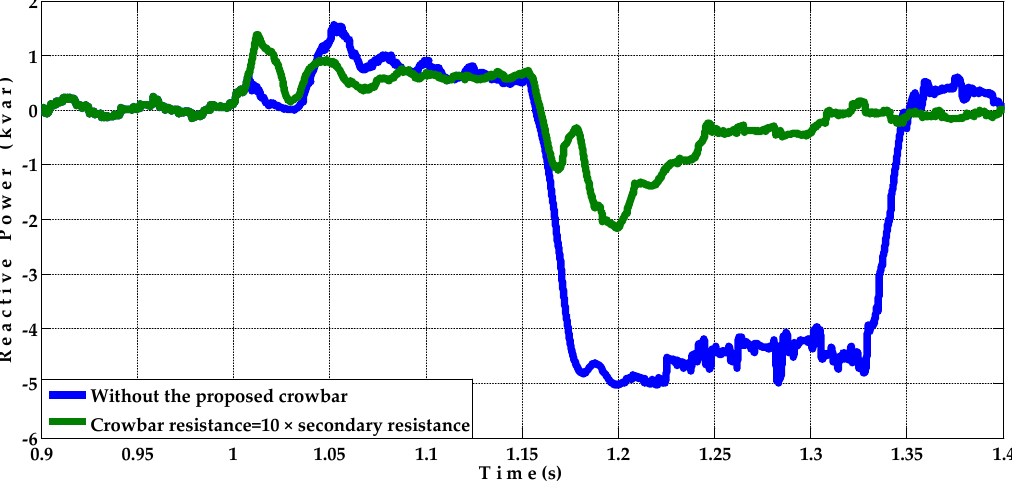
Figure 7. Reactive power of BDFRG with and without the proposed crowbar under symmetrical fault occurrence.